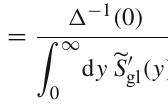
of the BSE system (5.3) (left panel), and the corresponding normalized curves (right